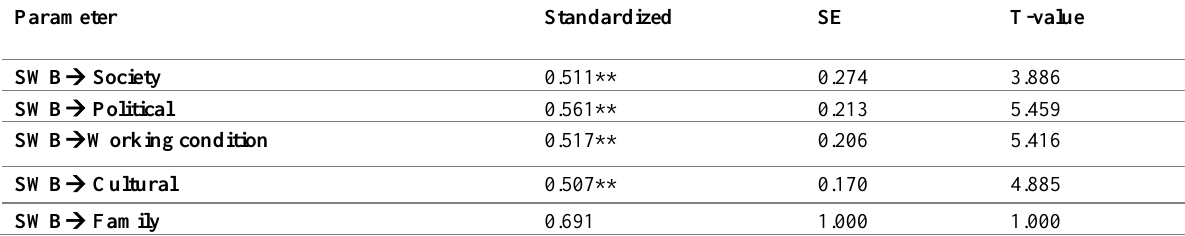
Table 6: Second Order Factor and Its First Order Factor’s Loadings(Chaiyamart,